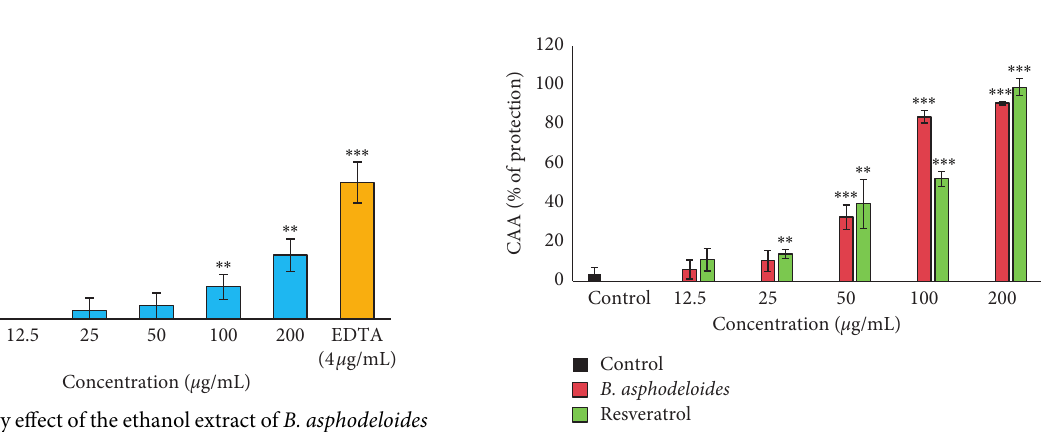
Figure 4: Cellular antioxidant activity of the ethanol extract of B. asphodeloides . Data are presented as the mean ± SD ( n � 3). ∗∗ P < 0 . 01 and ∗∗ ∗ P < 0 . 001 compared to the control. CAA: cellular antioxidant assay.